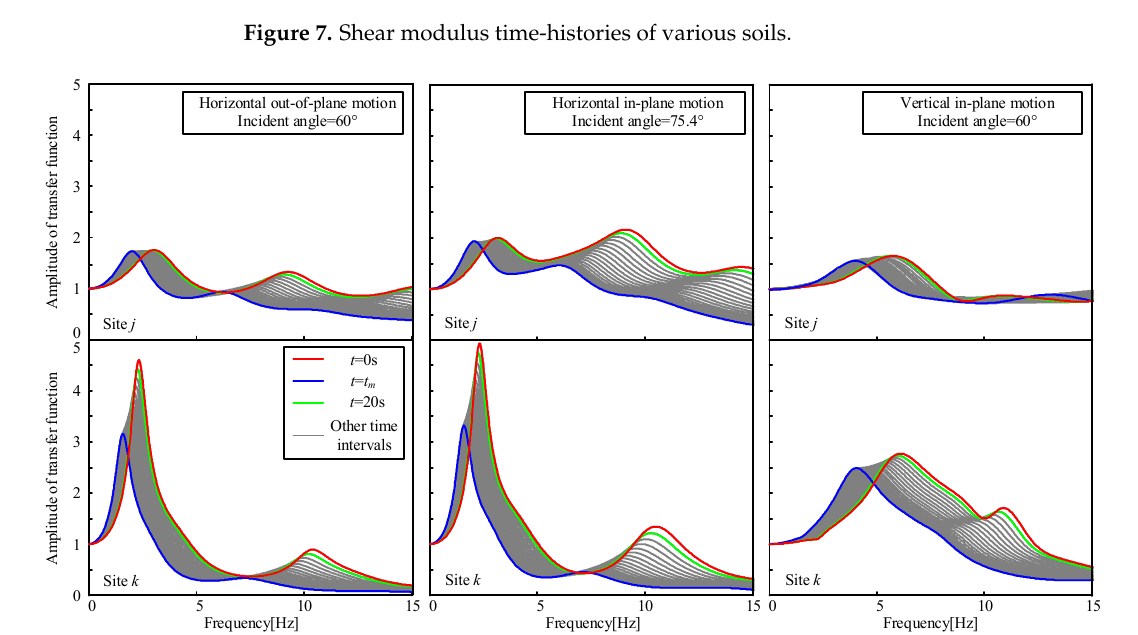
Figure 8. Time-varying transfer functions at sites j and k when Cs SI = 100 m/s, D SI = 5 m, and H SI = 5 m. (Note that tm is the time interval with respect to the lowest value of shear modulus).